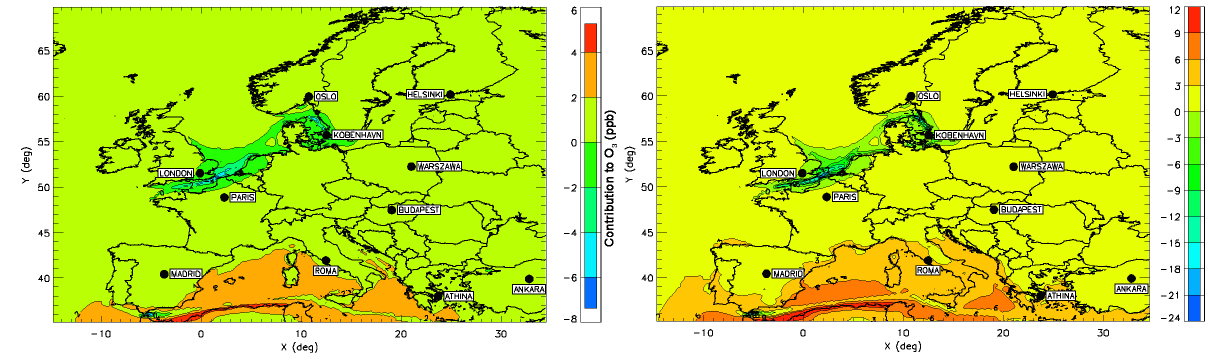
Figure 1. Contribution of ship emissions to mean surface O 3 in 2006: left in ppb (base case − no ship), right in % ((base case − no ship) × 100/(base